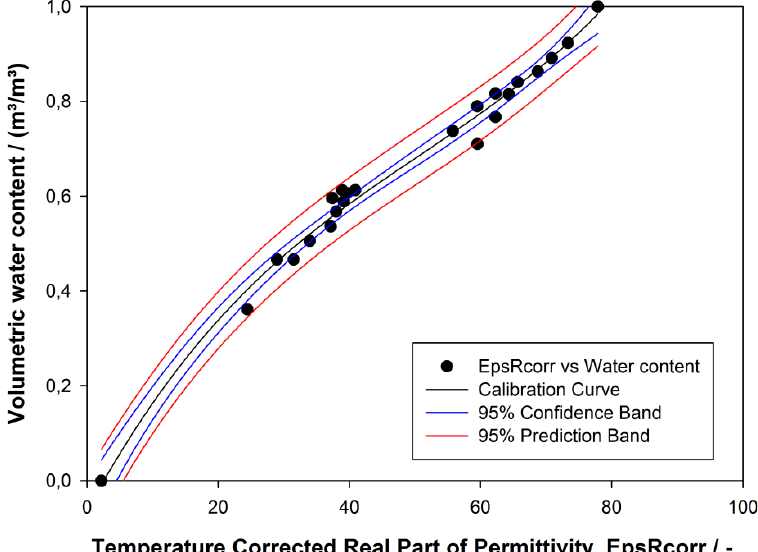
Figure 3. Fit of calibration function with a 3rd degree polynomial (all data points) [modified